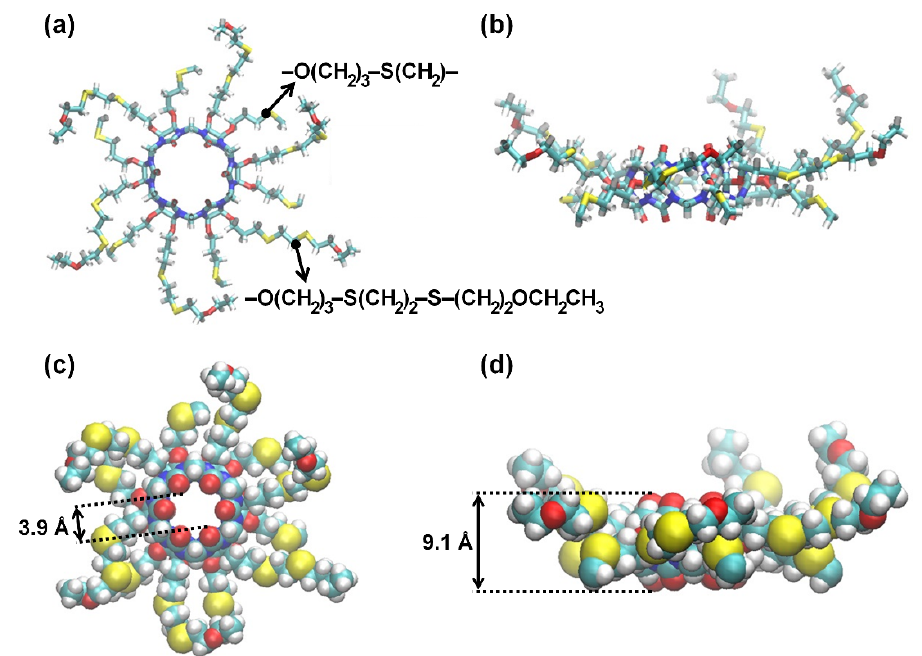
Figure 1. Top ( a , c ) and side ( b , d ) views of the modified CB[6] with six thioether bridges ( − O(CH 2 ) 3 − S(CH 2 ) − ) and dangling arms ( − O(CH 2 ) 3 − S(CH 2 ) 2 S − (CH 2 ) 2 OCH 2 CH 3 ). − O(CH 2 ) 3 − S(CH 2 ) − corresponds to a symmetric half of the linker. ( a , b ) do not include van der Waals spheres, whereas ( c , d ) do. Color scheme: N, blue; C, cyan; O, red; H, white; S, yellow.